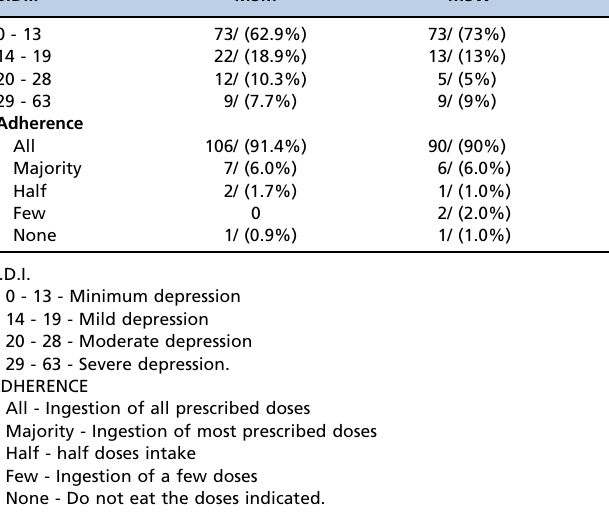
All - Ingestion of all prescribed doses Majority - Ingestion of most prescribed doses Half - half doses intake Few - Ingestion of a few doses None - Do not eat the doses indicated.